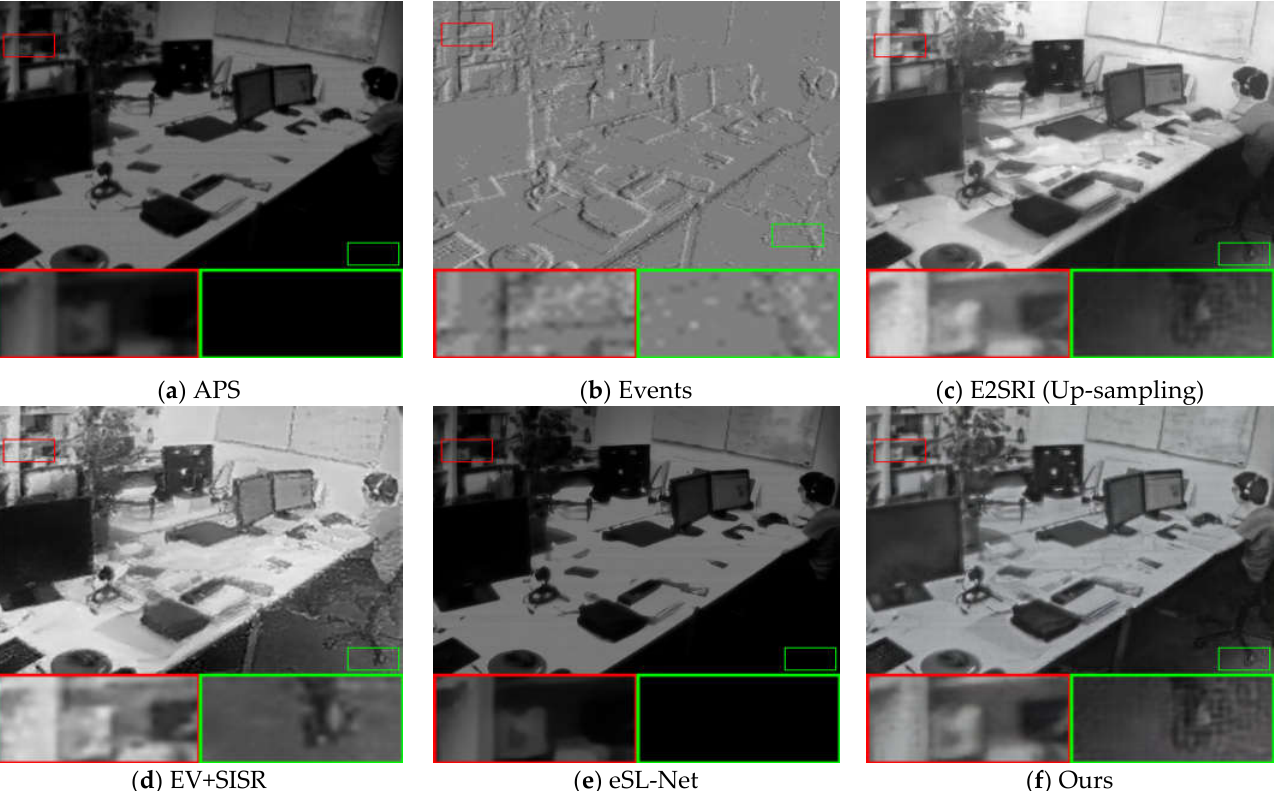
Figure 7. Comparison of the visual quality of our proposed method with other state-of-the-art meth- ods for 4× SR on real datasets. The APS frame and the 2× SR results of E2SRI are upsampled with bicubic interpolation to the corresponding scale for reference.